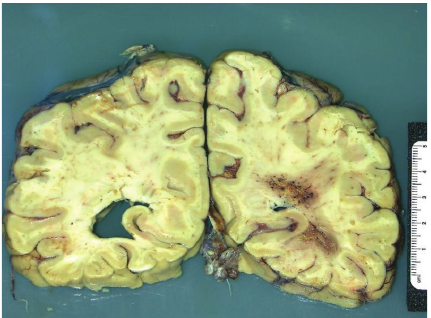
Figure 5: Gross autopsy image. A coronal section of the brain showing two grossly distinct, hemorrhagic lesions adjacent to the occipital horn of the right lateral ventricle associated with ventricular